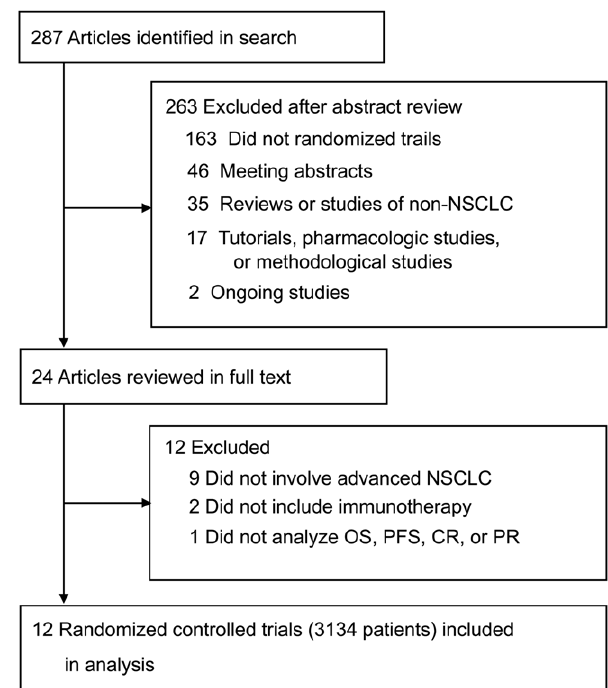
Figure 1. Study Flowchart.